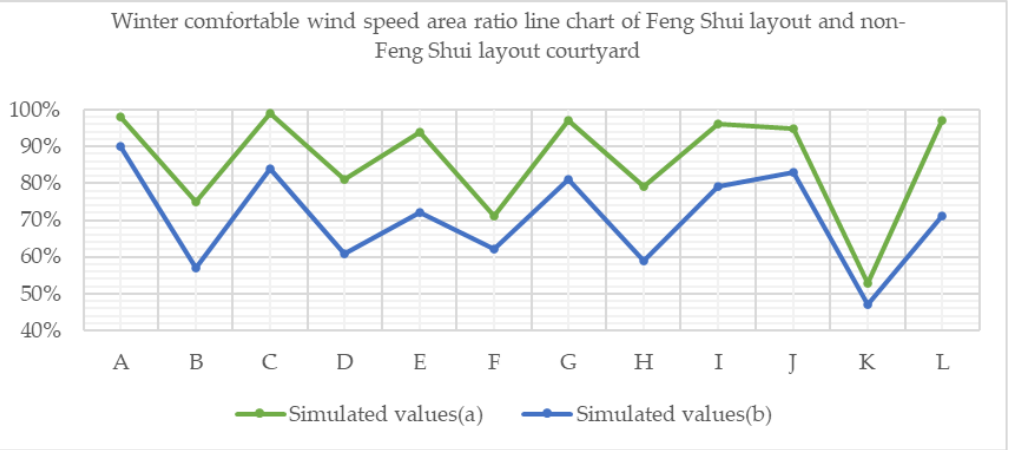
Figure 17. A line chart was created to compare the winter comfortable wind speed area ratio between the Feng Shui layout and non-Feng Shui layout courtyard. All data presented in the figures were obtained from the CFD simulations.